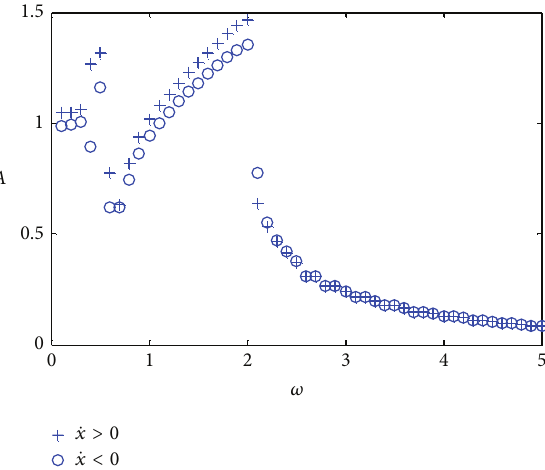
Figure 3: Amplitude frequency response characteristics.